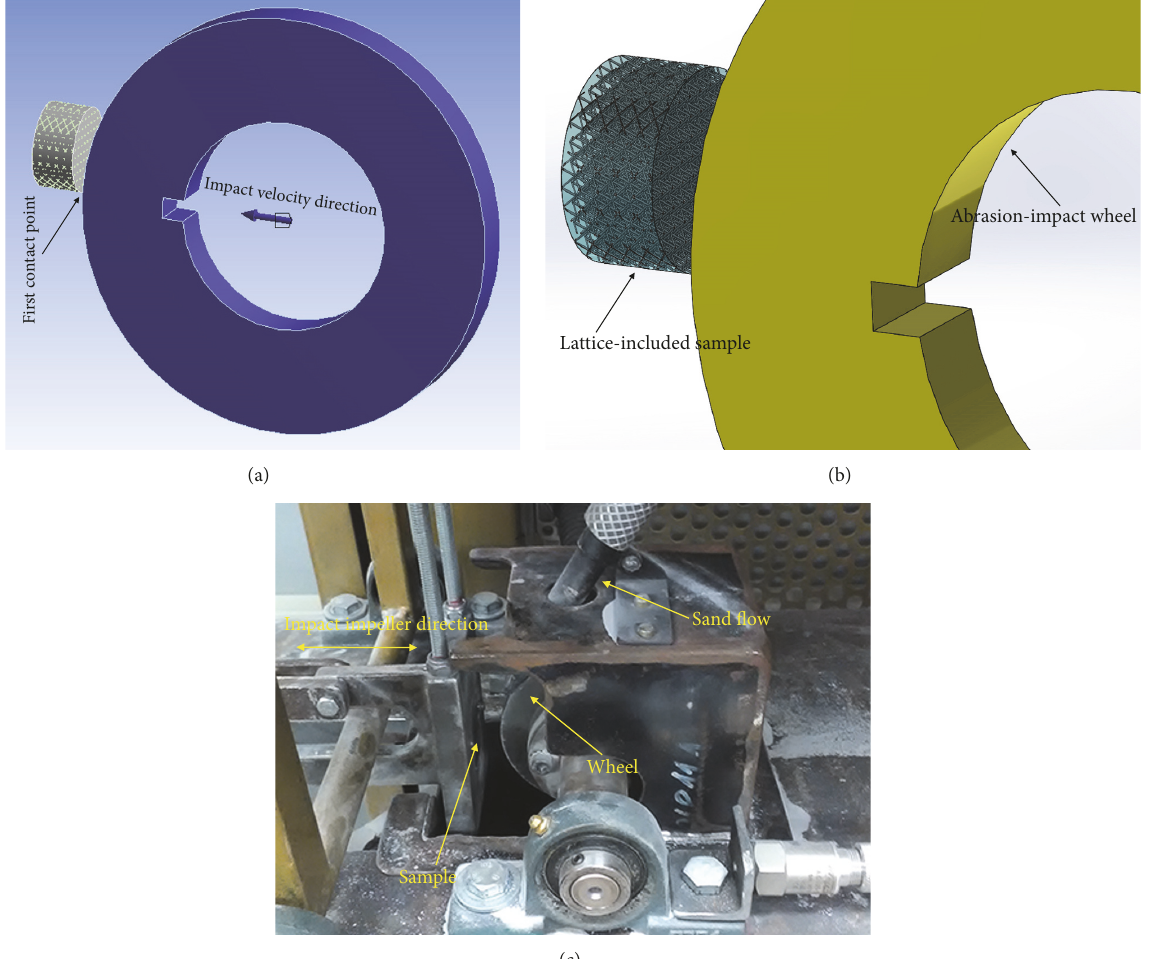
Figure 10: (a) Simulation mechanism, only horizontal impact motion, (b) schematic of wheel and lattice-included sample, and (c) position of sample and wheel in tribo-device laboratory [11].